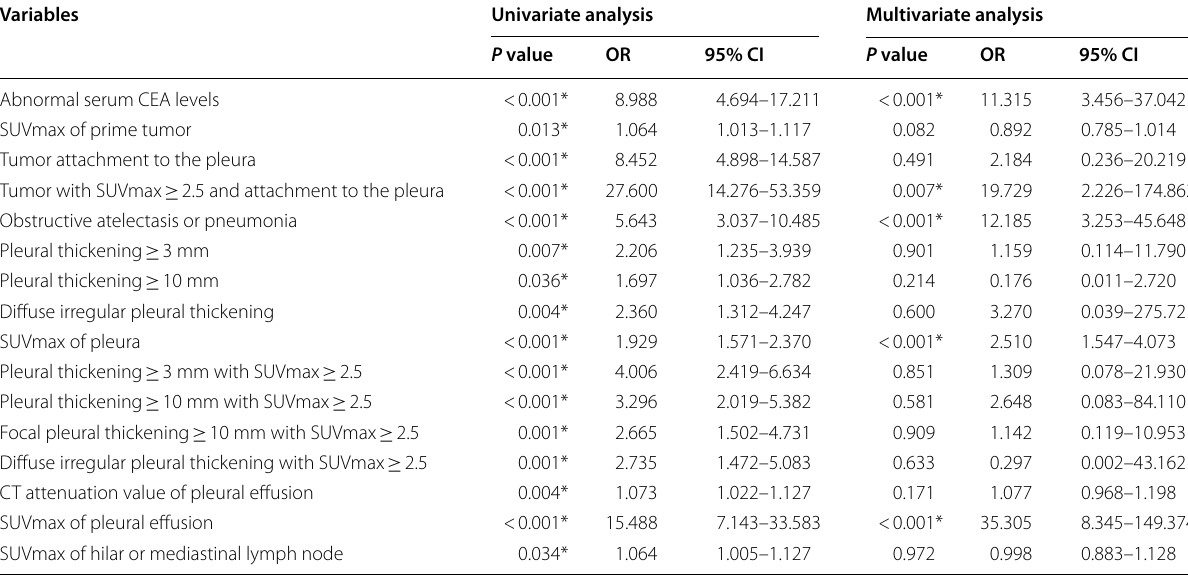
Table 2 Univariate and multivariate logistic regression analyses for the diagnosis of MPE in the training cohort